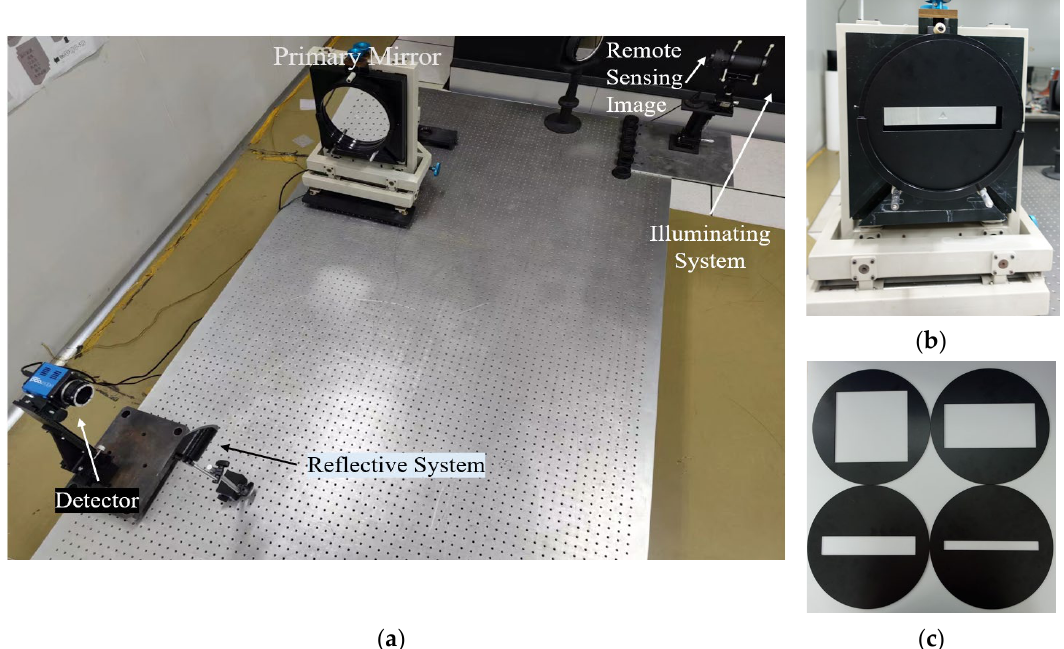
Figure 8. Semi-physical imaging experimental facilities. ( a ) The imaging experiment platform, ( b ) the primary mirror with a rectangular pupil optical element of length-width ratio 5, and ( c ) rectangular pupil optical elements.